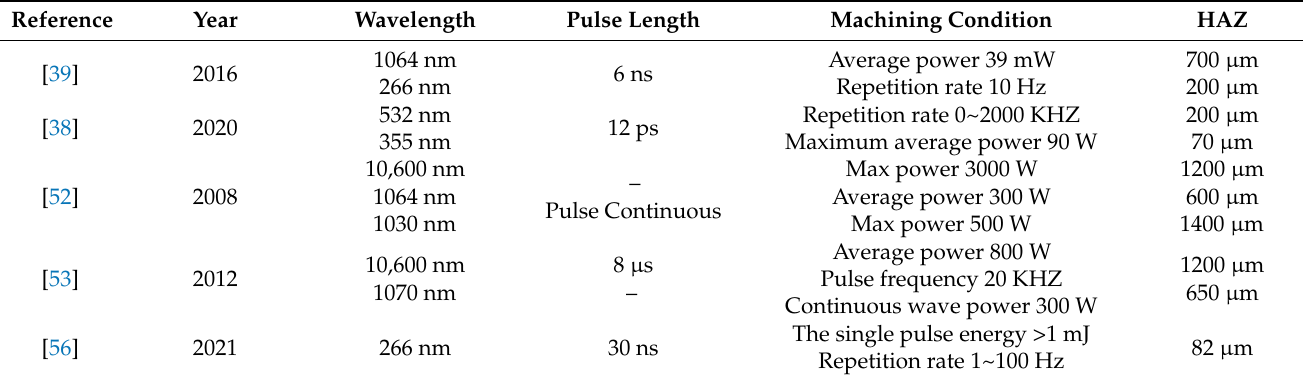
Table 1. Effect of wavelength on the size of the